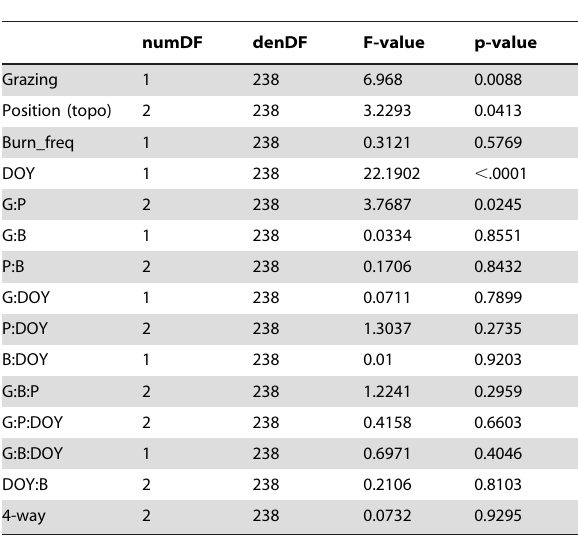
Table 3. Mixed-effects model results for NDVI by day of year and by landscape contrasts: grazing (grazed/ungrazed), topographic position (upland, slope, lowland), and burn frequency (1, 2, 4, 10, 20).